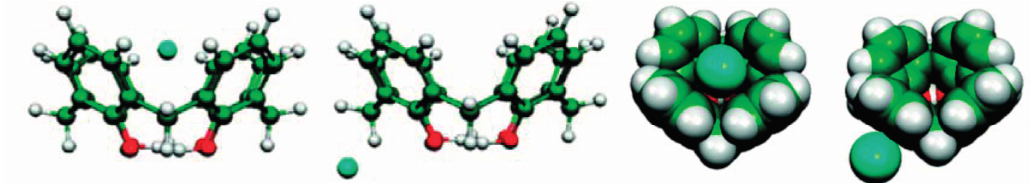
Figure 12. Calix[4]arene complexes with argon; optimized structures of endo-complex and exo-complex. Reprinted from ref. [47,48] with permission of the Royal Society of